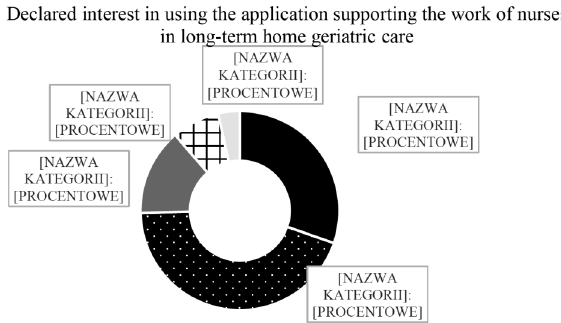
Figure 3. Declared interest in using the application (n =